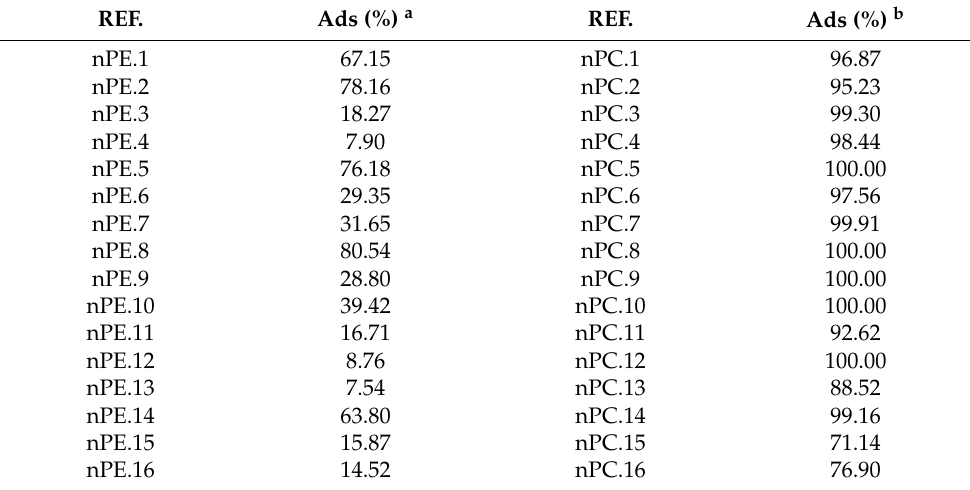
Table 2. Adsorption (%) from the initial PC and PE concentrations under different synthesis condi- tions (DOE) using supernatant measurements (UV-VIS).